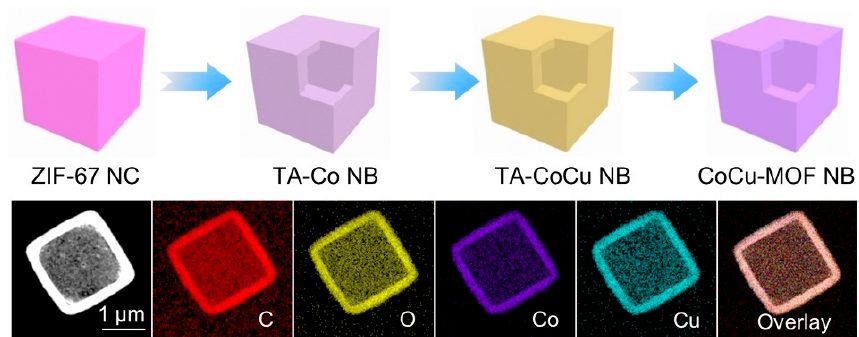
Figure 4. Schematic diagram of CuCo-MOF prepared by ion exchange method . Adapted with per- mission from Ref. [54], 2023, John Wiley and Sons. permission from Ref. [54], 2023, John Wiley and